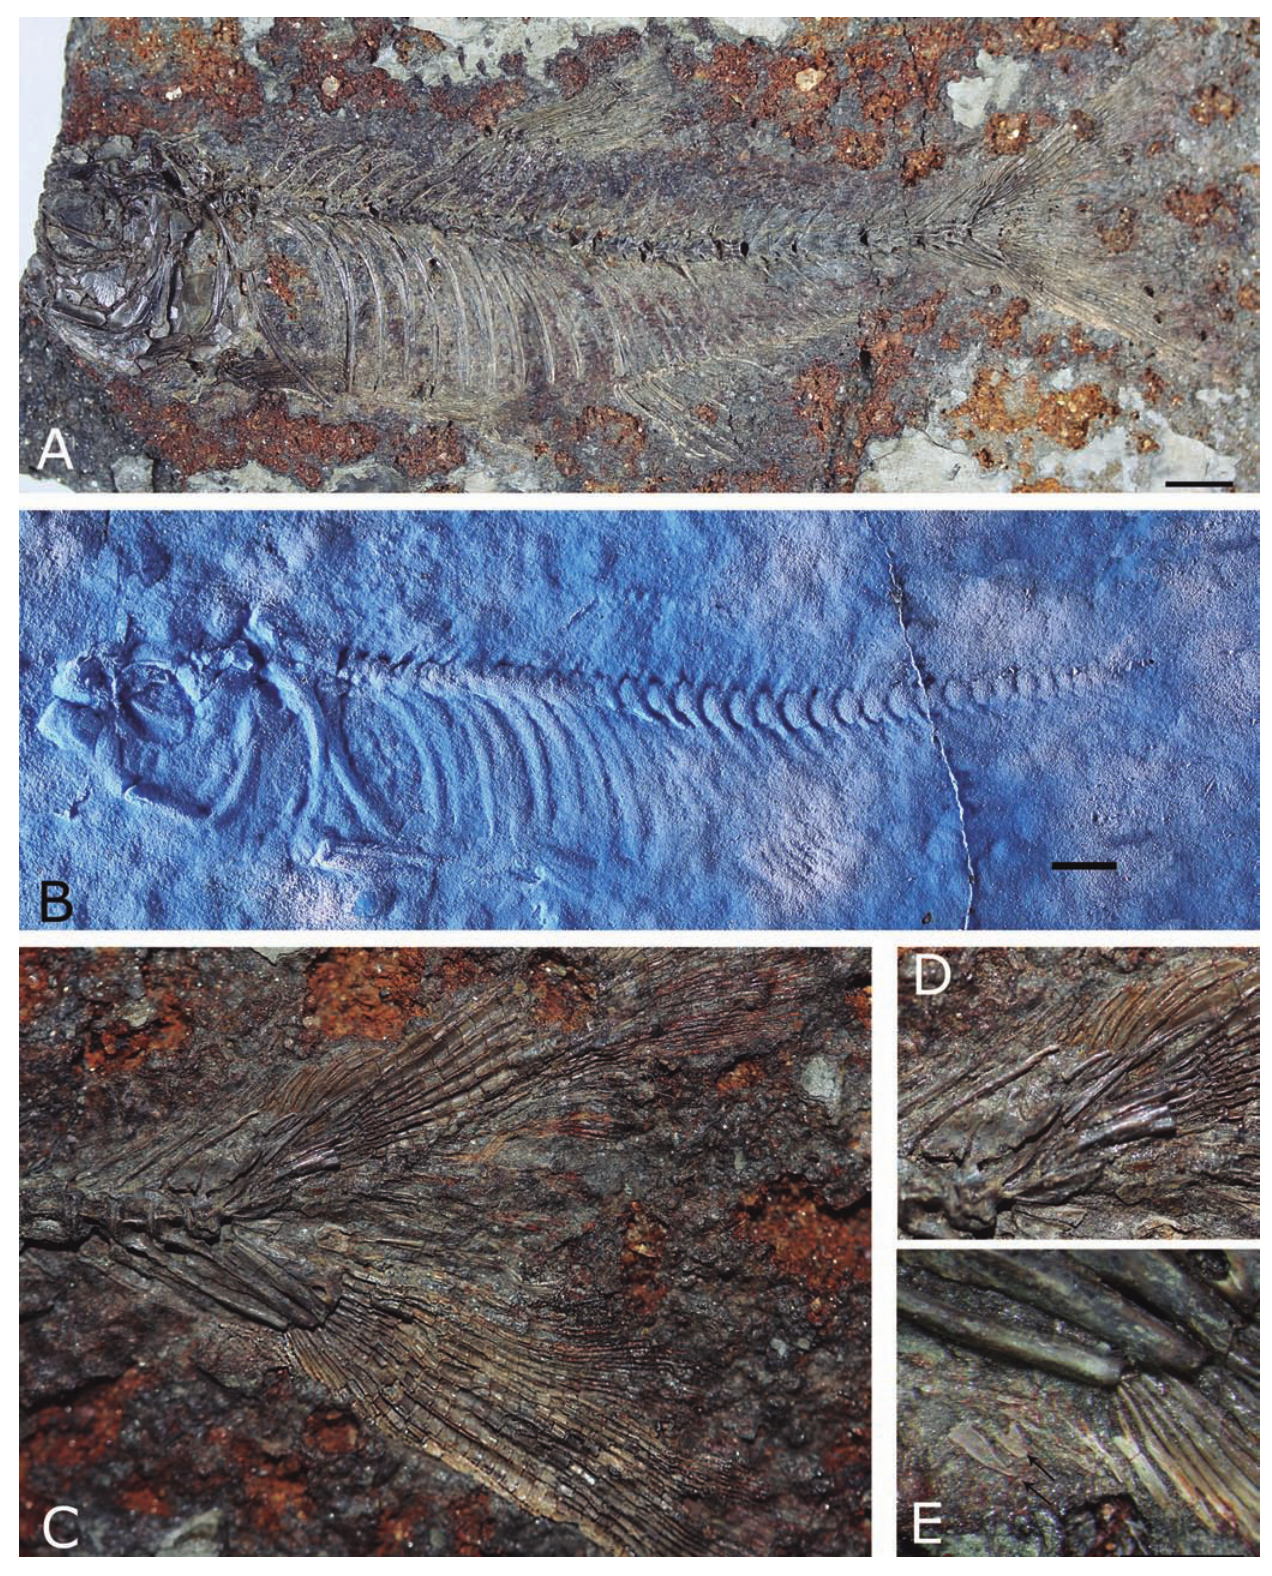
Fig. 2. † Bryconetes enigmaticus n. gen. n. sp., holotype, UFRGS 19114. A, fossil specimen as preserved in lateral view; B, silicone peel from the counterpart; C, posterior part of the fish, with the caudal fin; D, enlargement of the caudal fin skeleton illustrating the modified neural arches and dorsal procurrent fin rays; E, detail of the anteriormost ventral procurrent rays showing the fused laminar rays (arrows). Scale bars = 5